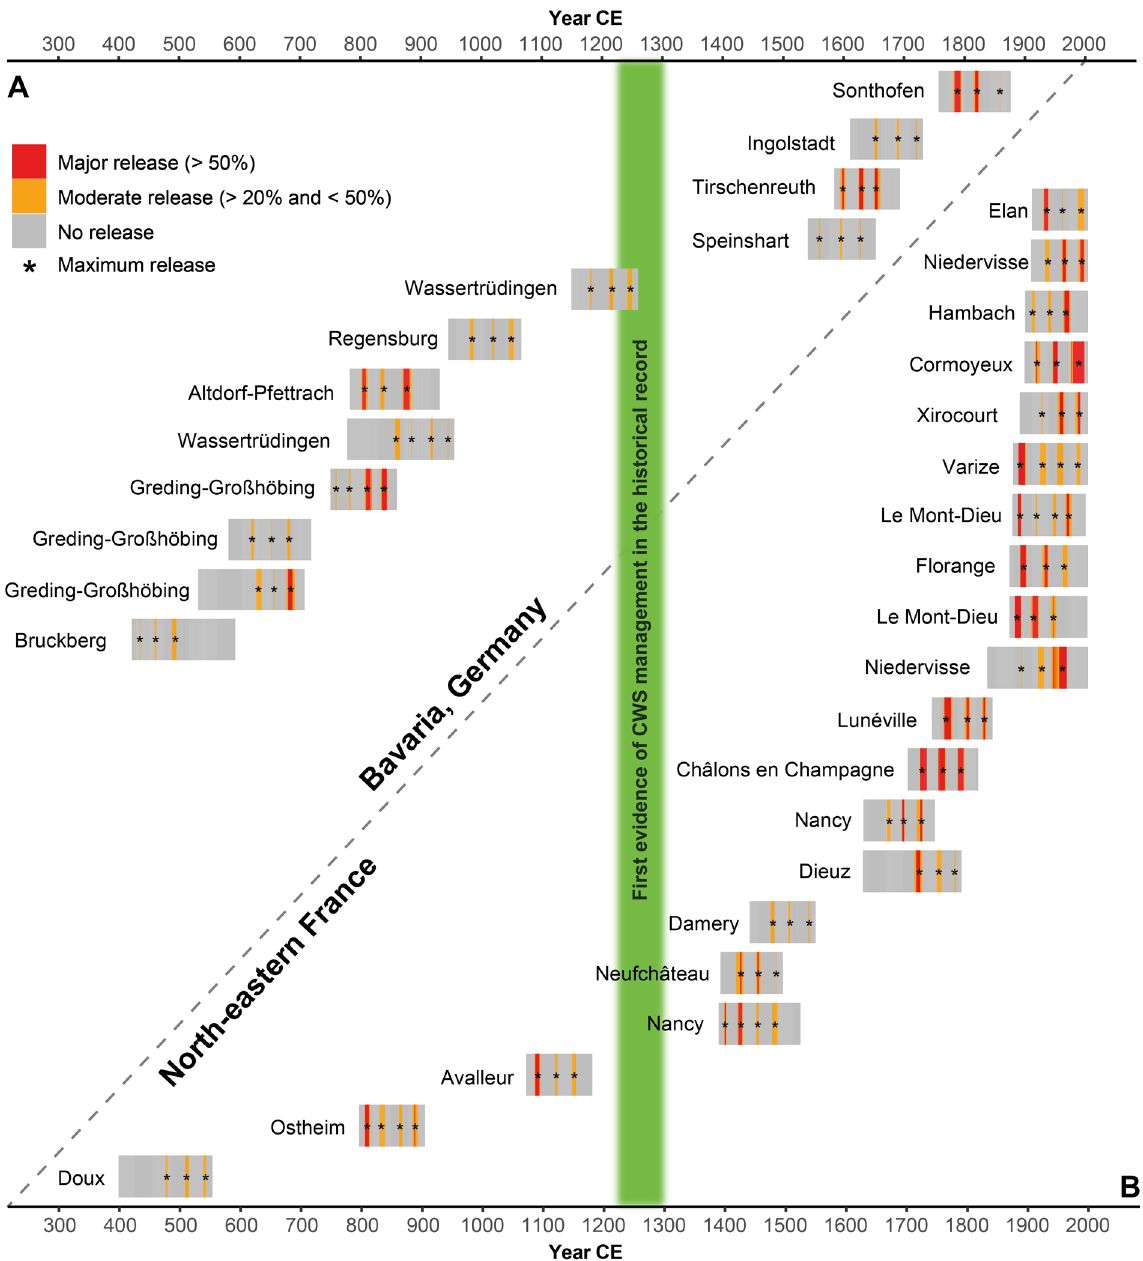
Figure 4. Bar graphs of detected possible CWS standards from the historical dataset for Bavaria ( A ) and north- eastern France ( B ). Major release events are shown in red, moderate release events in orange. Release maxima are highlighted (black stars). The period of early historical records for CWS management is indicated (green). This figure was created using R software (https ://www.r-proje